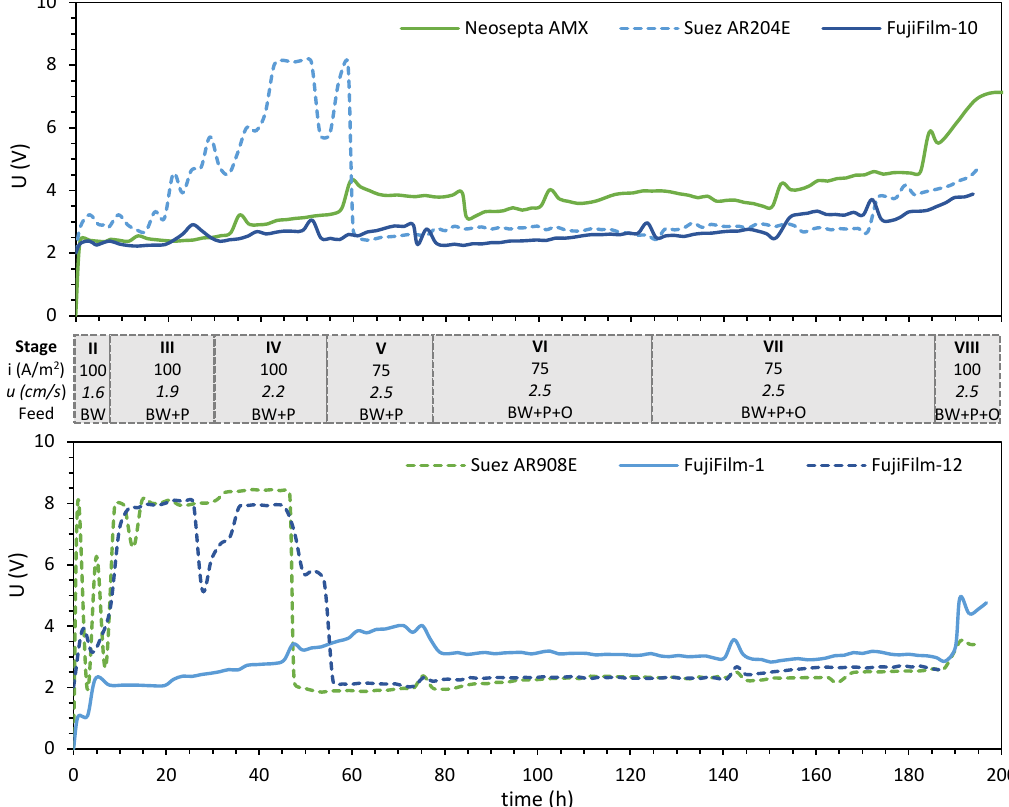
Figure 3. Electric potential U versus time during the EDR runs with stacks containing di ff erent AEMs. Chronologically, the experiments were performed in the following order: Neosepta AMX, Suez AR204E, FujiFilm-10, Suez AR908E, FujiFilm-1, and